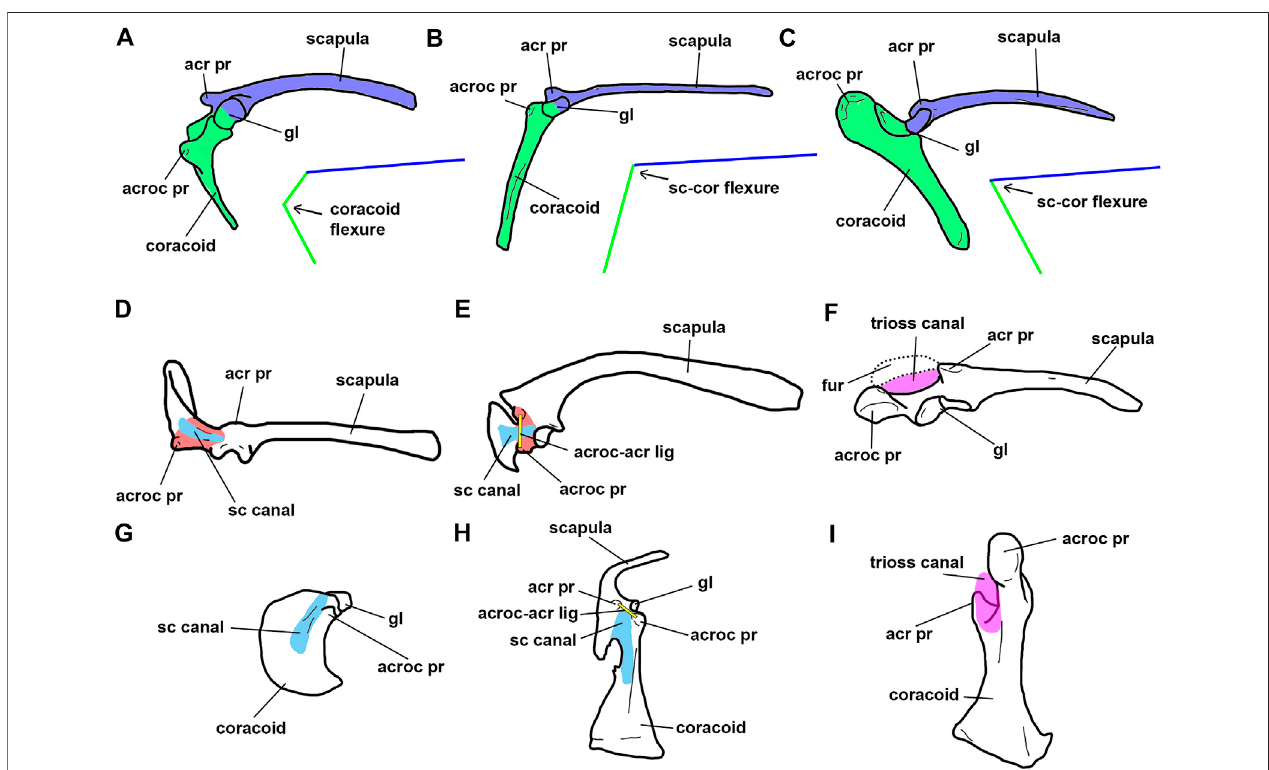
FIGURE 3 | Selected paravian scapulocoracoid in lateral (A – C) , dorsal (D – F) and anterior (G – I) views. (A, D, G) : Archaeopteryx lithographica ; (B, E, H) , Rhea americana ; (C, F, I) , Vultur gryphus . Abbreviations. acr pr, acromion process; acroc pr, acrocoracoid process; acroc-acr lig, acrocoraco-acromial ligament; fur, furcula; gl, glenoid; sc canal, supracoracoid canal; trioss canal, triosseal canal. Blue, scapula; red, coracoidal plate; green, coracoid; light blue, supracoracoid canal; yellow, acrocoraco-acromial ligament; violet, triosseal canal. Not to